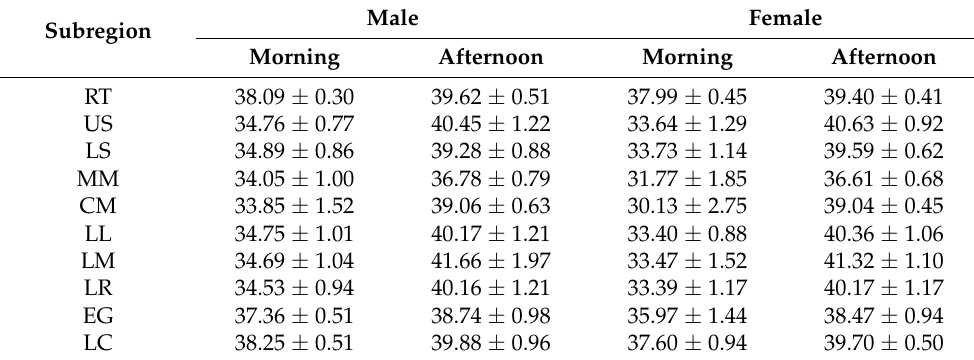
Table 2. Mean and standard deviation of rectal temperature and body surface temperature measure- ments obtained by infrared thermography.